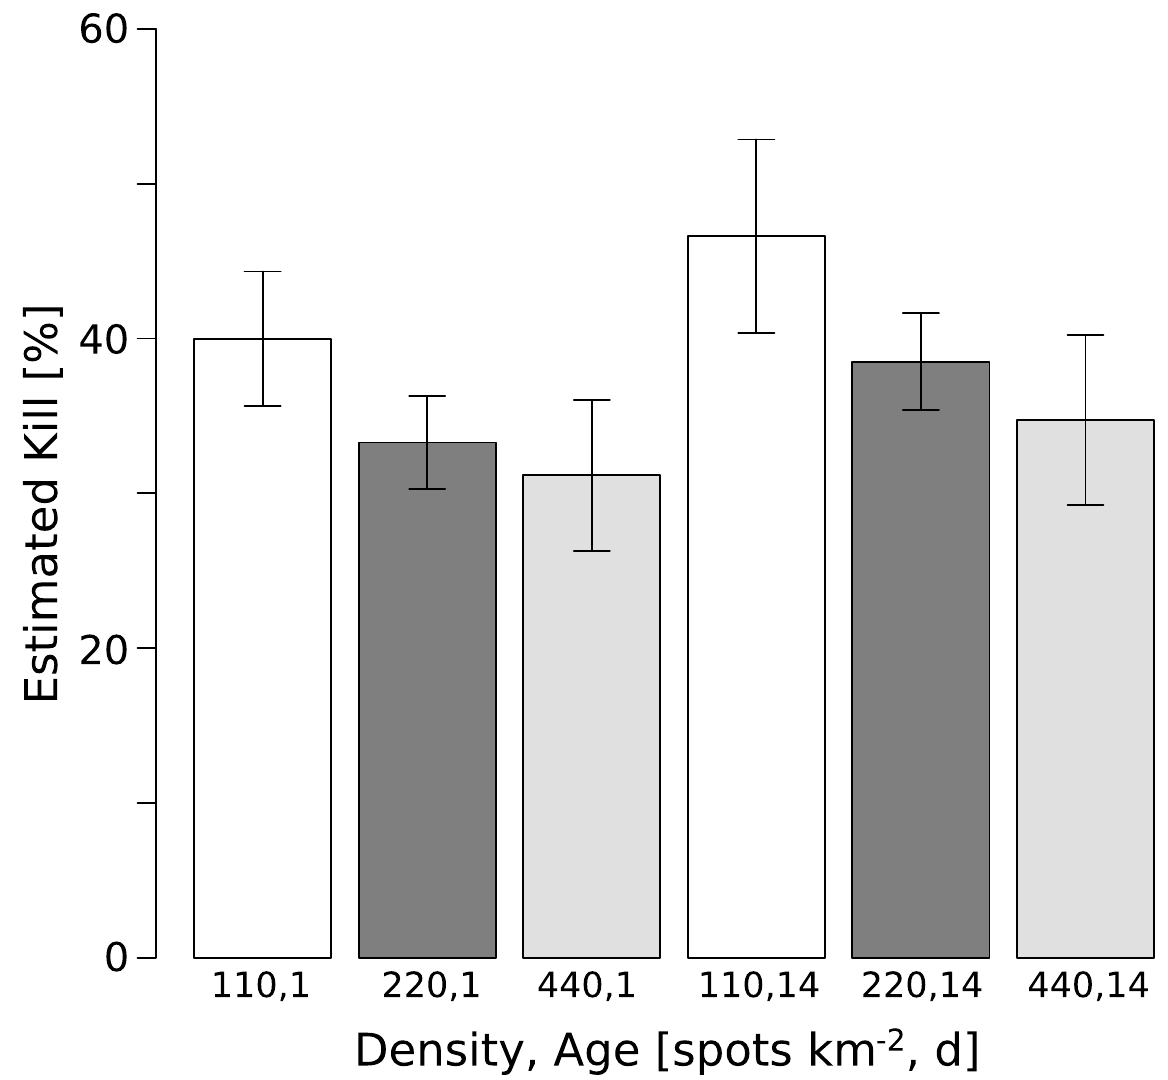
Fig 1. Mean and SE of estimated percent males killed for each application density and grid age. Percentages were calculated via dividing the estimated male kill by the product of the number of pupae per release, proportion emergence, proportion flight ability, proportion ME responders, and 0.5 (assuming an even sex ratio).